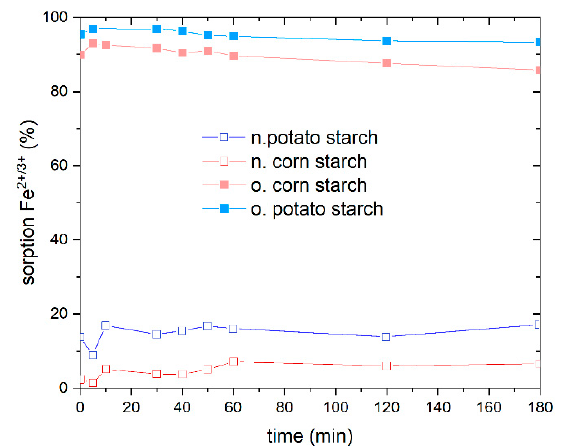
Figure 4. Effect of time on the percentage adsorption of Fe 2+/3+ from FeSO 4 with an initial concentration of Fe 2+ ions of 10 mg/L on native potato starch (blue), native corn starch (red), oxidized potato starch (light blue) and oxidized corn starch (pink). The percentage adsorption of SO 4 2 − from FeSO 4 is presented in Figure S4 in SI.